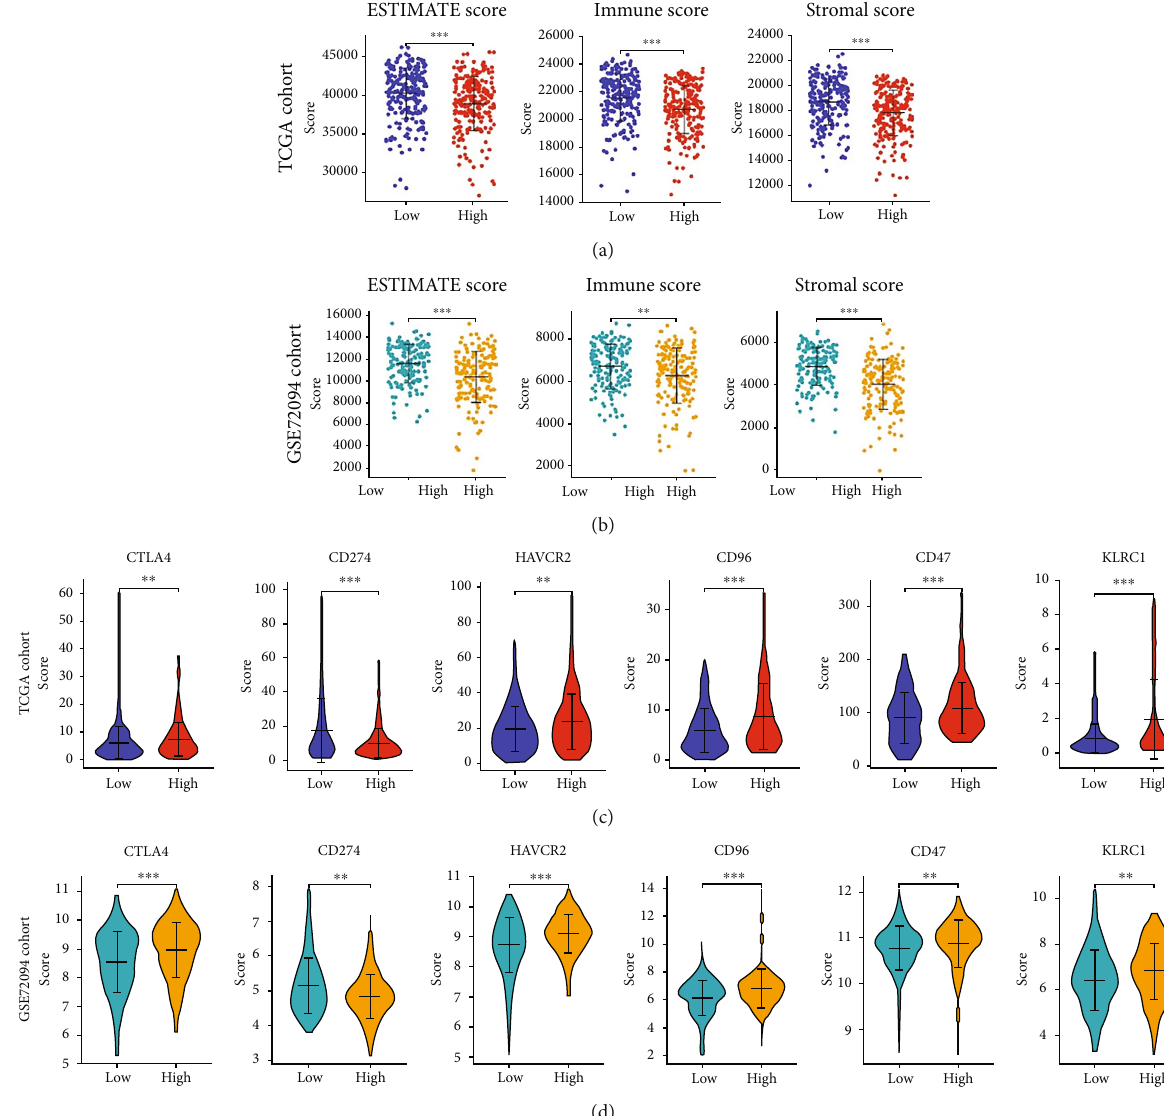
Figure 7: Immune cell in fi ltration landscape of LUAD. (A, B) ESTIMATE, immune and stromal scores of high- and low-risk patients in TCGA (a) (n =447) and GSE72094 (b) (n =328) datasets. (C, D) The expression levels of immune checkpoint molecules in the high- and datasets. The asterisks represent the